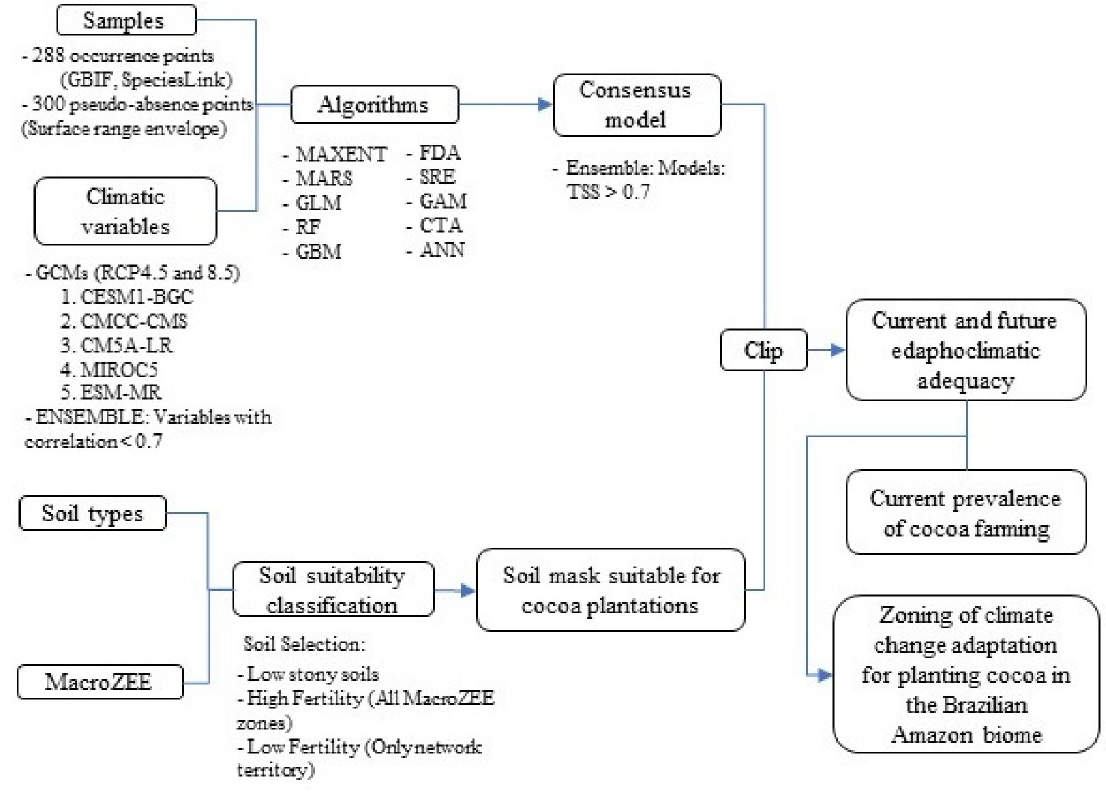
Fig 2. Summary of all methodological